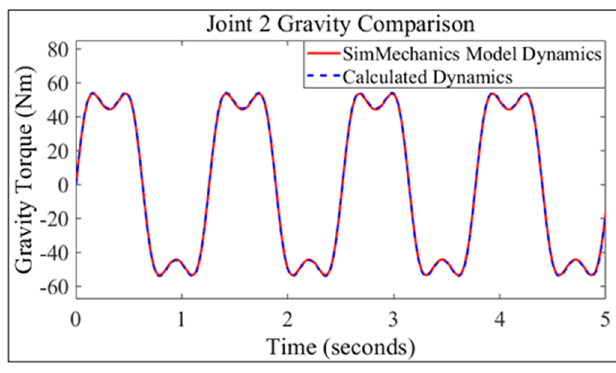
Figure 4. Comparison of dynamics [26].